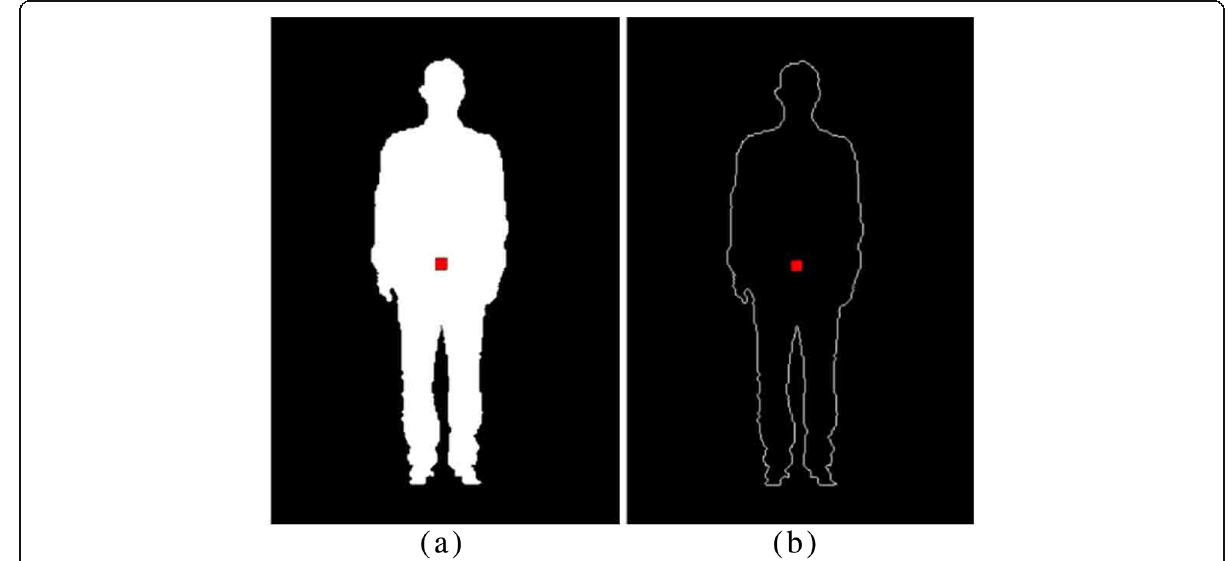
Fig. 3 Center of gravity in the human body area and human contour